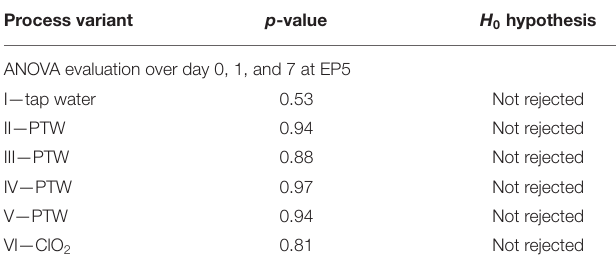
TABLE 3 | Statistical evaluation of storage day 1.